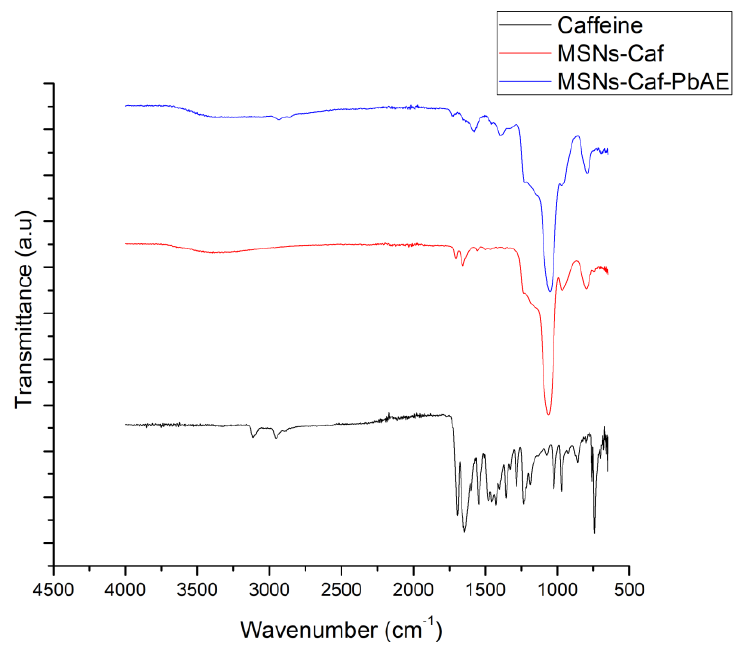
Figure 3. FTIR spectra of MSNs, MSNs-Caf, and MSNs-Caf-PbAE.